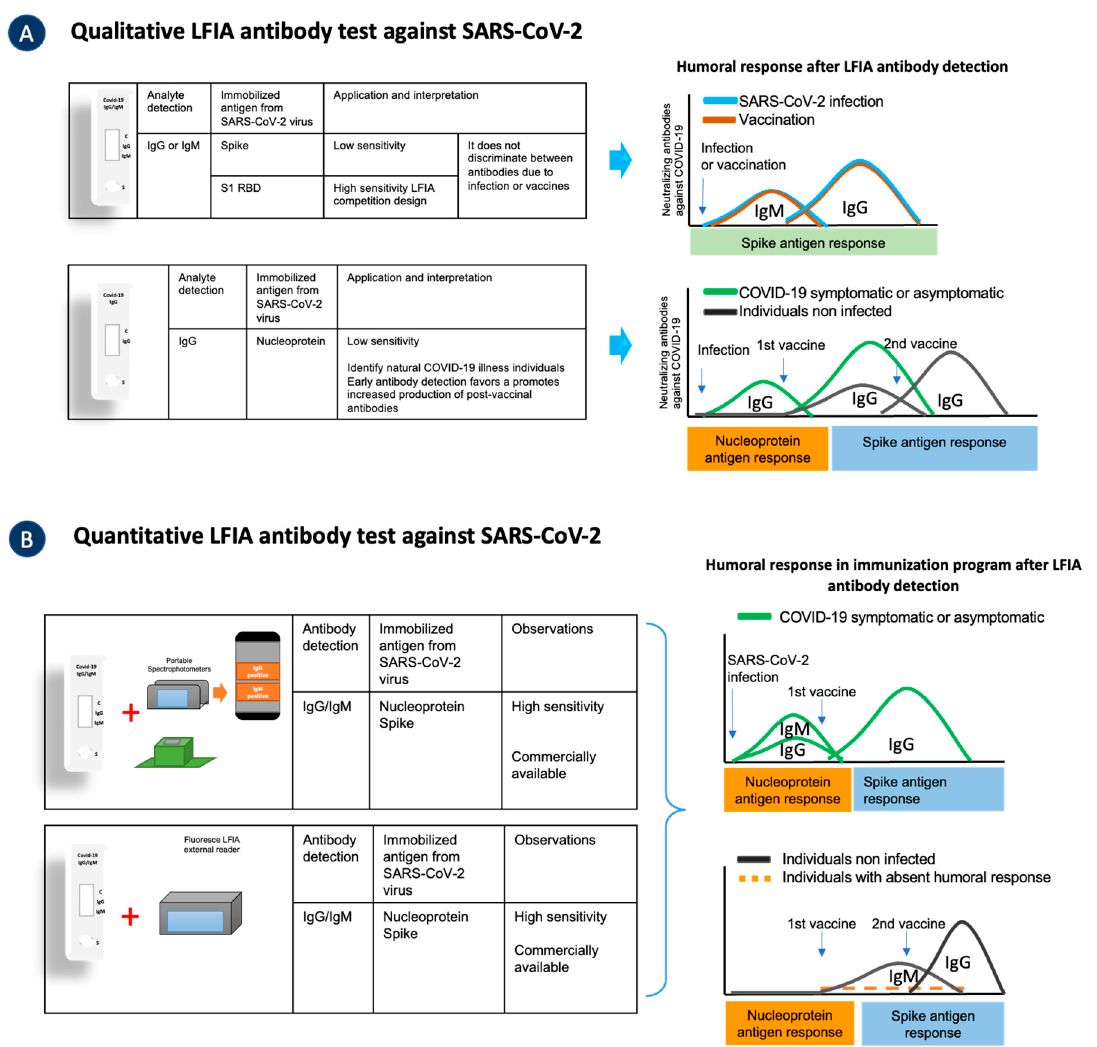
Figure 3. LFIAs detect IgG and/or IgM antibodies in asymptomatic, symptomatic, and immunized individuals. A. LFIAs with qualitative readouts are available with the SARS ‐ CoV ‐ 2 NP antigenic protein and the S protein. B. LFIAs coupled to portable spectrophotometer have a greater sensitivity for evaluating the humoral response of convalescent, symptomatic, asymptomatic, and immunized individuals. The graphs on the right indicate the interpretation of LFIA results showing the humoral response in SARS ‐ CoV ‐ 2 infected and uninfected individuals and those who have received at least the first dose of vaccine.